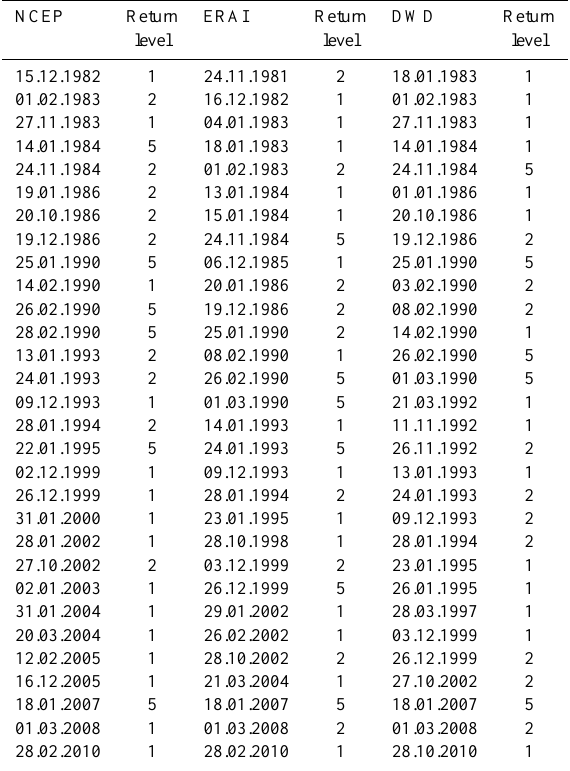
Table 1. List of the identified top 30 events and corresponding re- turn level for each event for NCEP, ERAI and DWD gust data. Dates are given as dd.mm.yyyy.